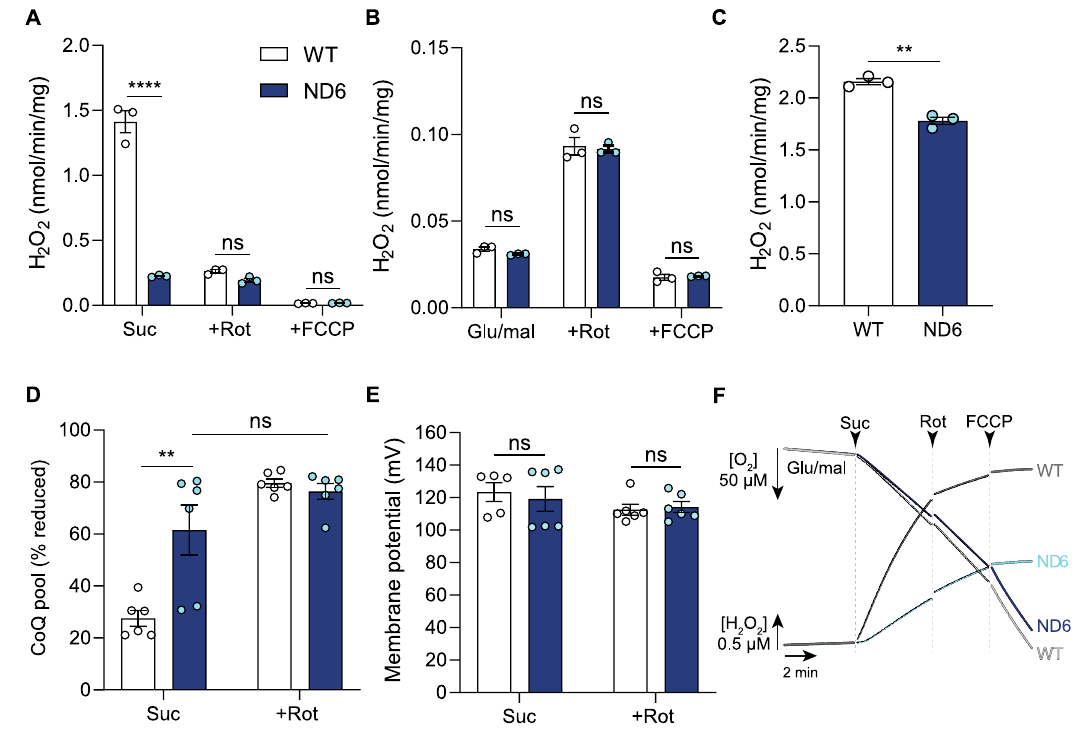
Fig. 3 ND6-P25L complex I does not catalyze reverse electron transfer. Rates of production of H 2 O 2 by isolated mitochondria from WT and ND6-P25L mouse hearts incubated with ( A ) succinate (10 mM) or ( B ) glu/mal (glutamate/malate; 10 mM of each). FCCP (5 µ M) or rotenone (5 µ M) were added as indicated. The data were obtained using a kinetic plate reader at room temperature and are mean averages ± S.E.M. ( n = 3, where each replicate is from an independent mitochondrial preparation on a different heart) evaluated using a two-way ANOVA test with Tukey ’ s multiple comparisons correction (**** p < 0.0001). C Production of H 2 O 2 by mitochondrial membranes isolated from WT and ND6-P25L mouse hearts incubated with NADH in the presence of piericidin A. The data are mean averages ± S.E.M. ( n = 3, from three independent preparations each comprising four or fi ve hearts)